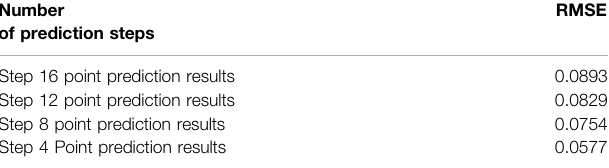
TABLE 1 | Point prediction error